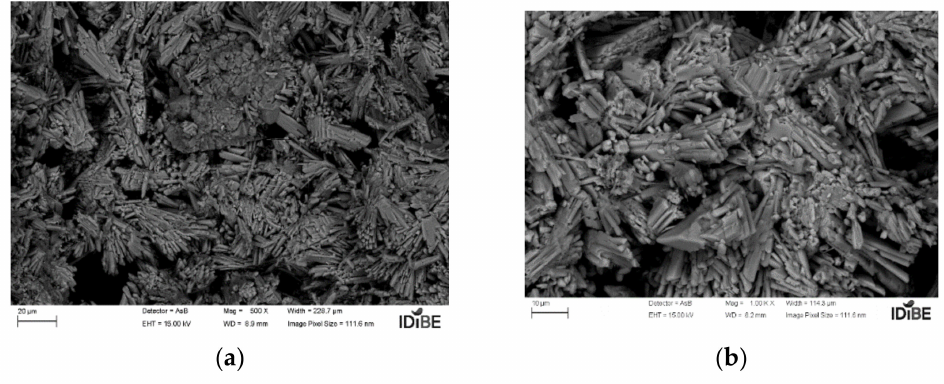
Figure 8. Additive plaster 1—Y1 micrograph: ( a ) 20 µ m; ( b ) 10 µ m (source: the